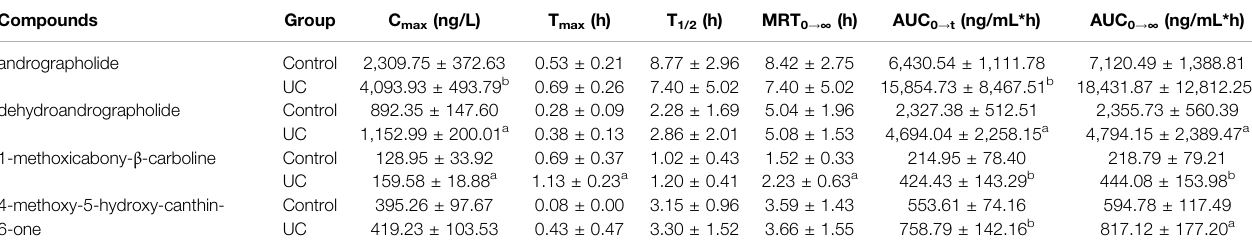
TABLE 6 | The main pharmacokinetic parameters of the four compounds in rat serum after oral administration of XLF ( n = 8).